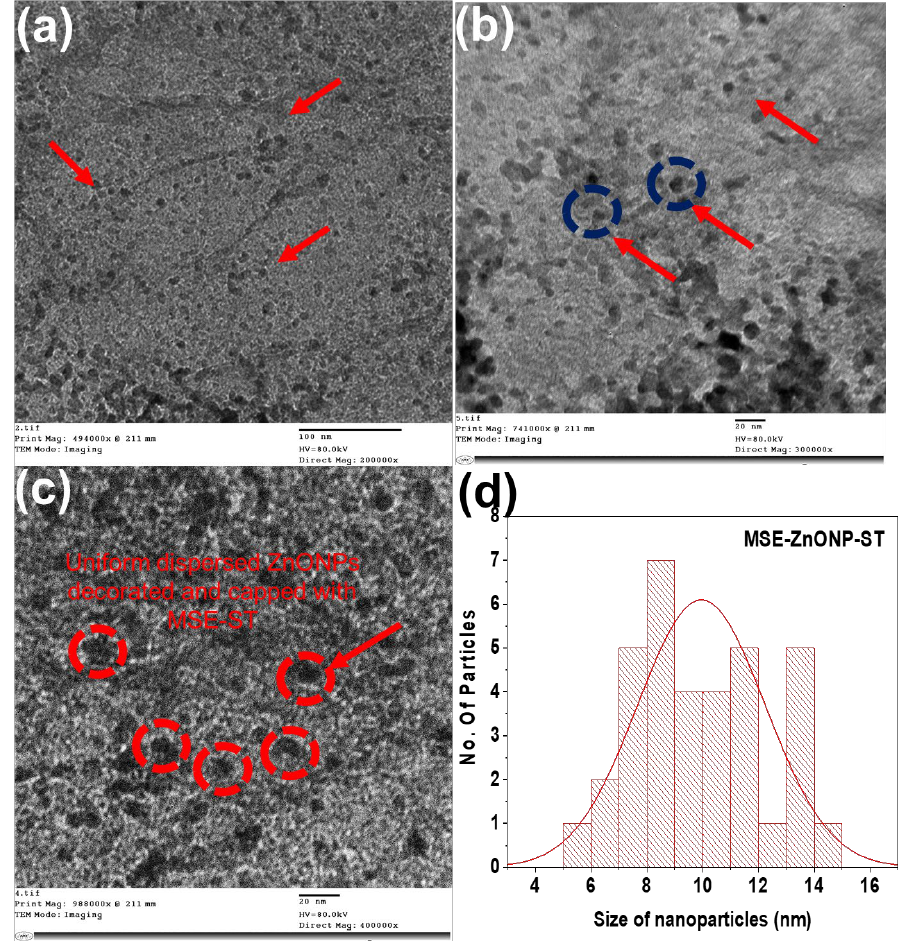
Figure 2. TEM image of ( a ) MSE-ZnONP-ST and ( b , c ) corresponding high-magnification images. ( d ) Histogram of ZnONP dispersion in MSE-ZnONP-ST (the dispersion of ZnONPs is depicted by red arrows and circles). Table 1. Chemical composition of untreated and treated cotton hand embroidery threads. Sample